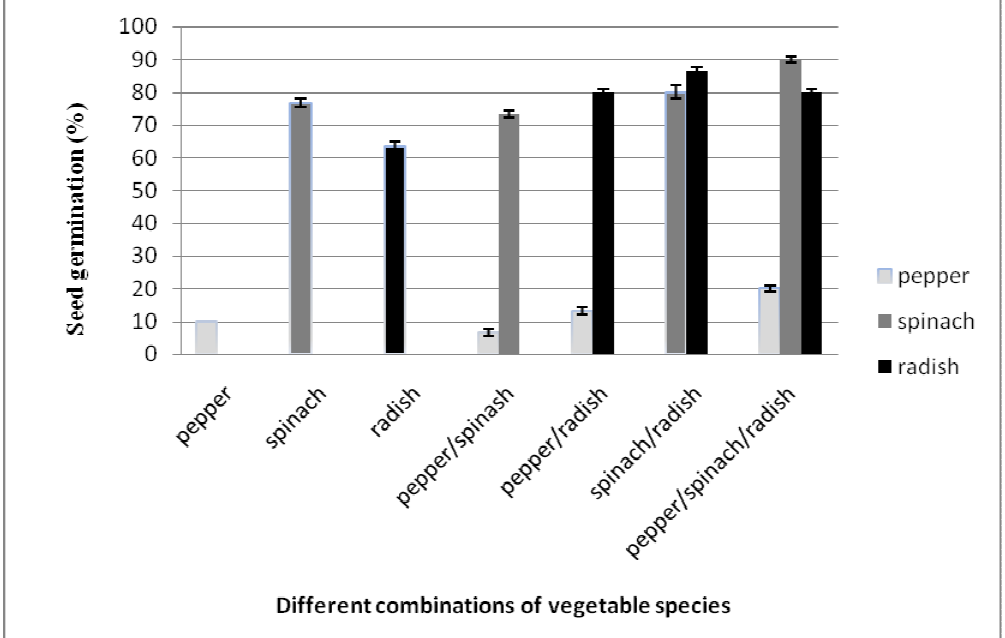
Figure 2. Allelopathic effect between selected vegetables on seed